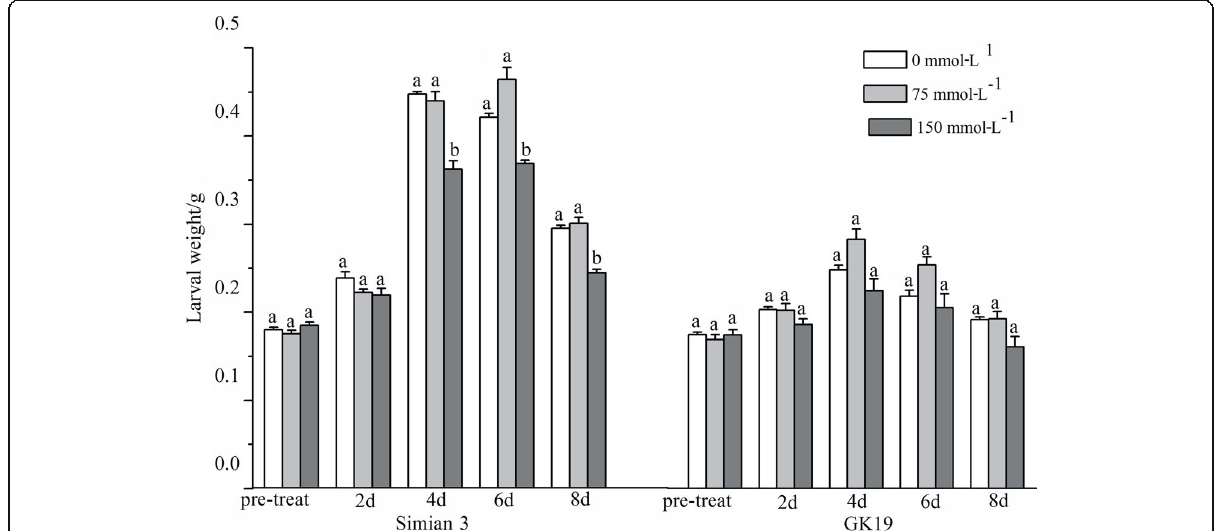
Fig. 4 Larval weight of H. armigera larvae fed GK19 and Simian 3 grown under NaCl stress. Mean ± (SE); Significant difference in lowercase letters at 0.05 level between NaCl stress treatments